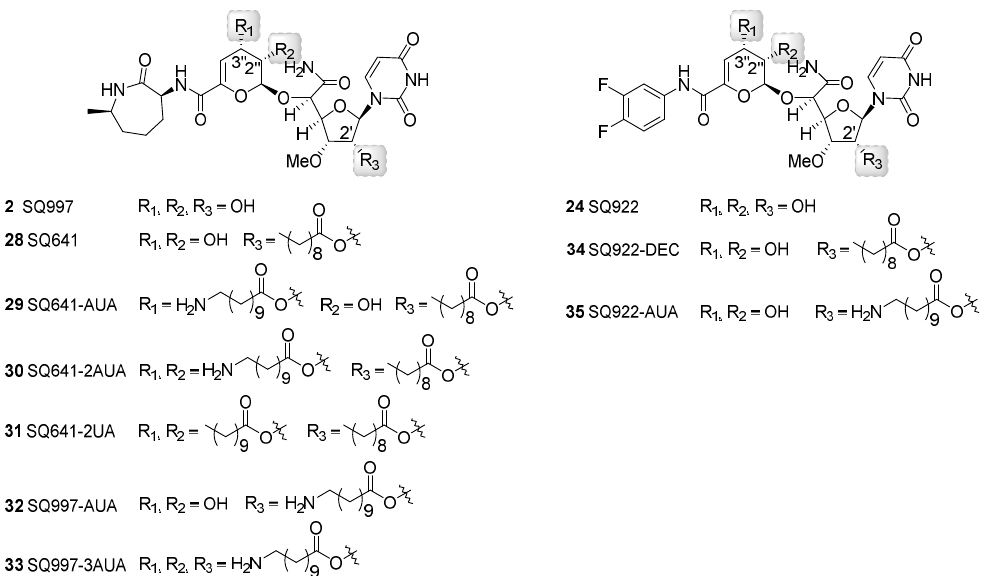
Figure 7. Structures of capuramycin analogs generated through semisynthesis and modified with decanoic acid (DEC), undecanoic acid (UA), and/or aminoundecanoic acid (AUA).